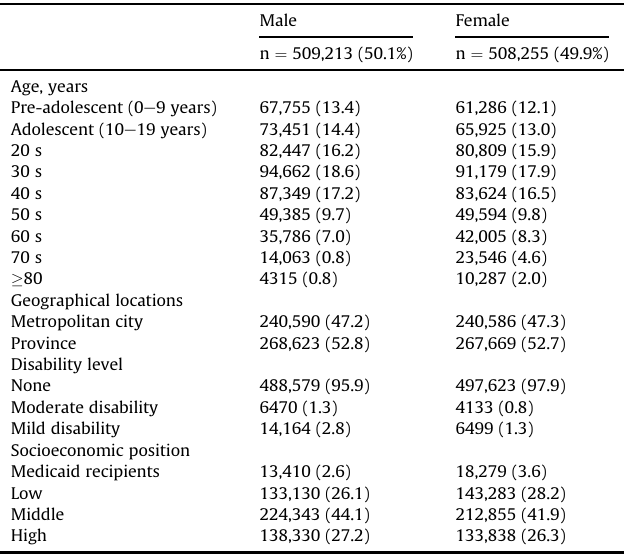
Table 1 General characteristics of study subjects by